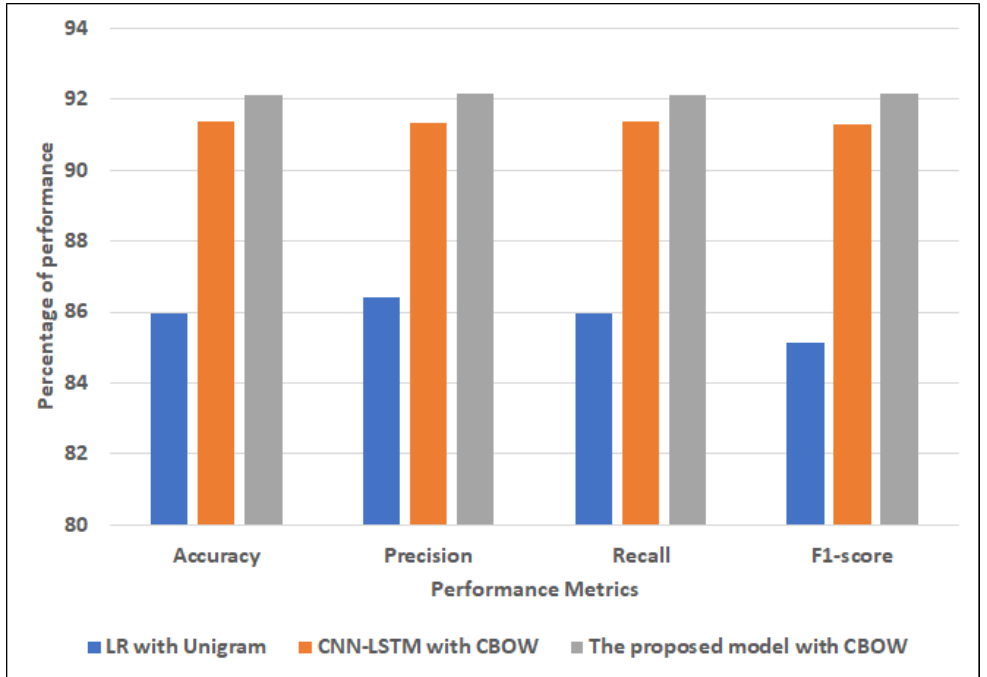
Figure 8. The best models for the Main-AHS